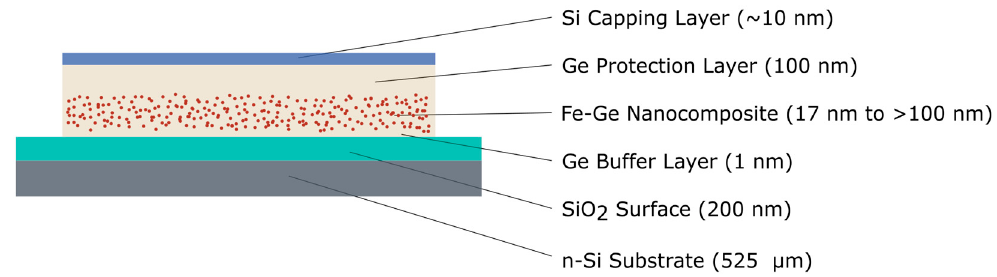
Figure 3. Cross-section through the layers of a co-deposited nanocomposite sample. The individual thicknesses are given in the drawing. Contact lines are not included in the sketch but can be seen in Figure 2.